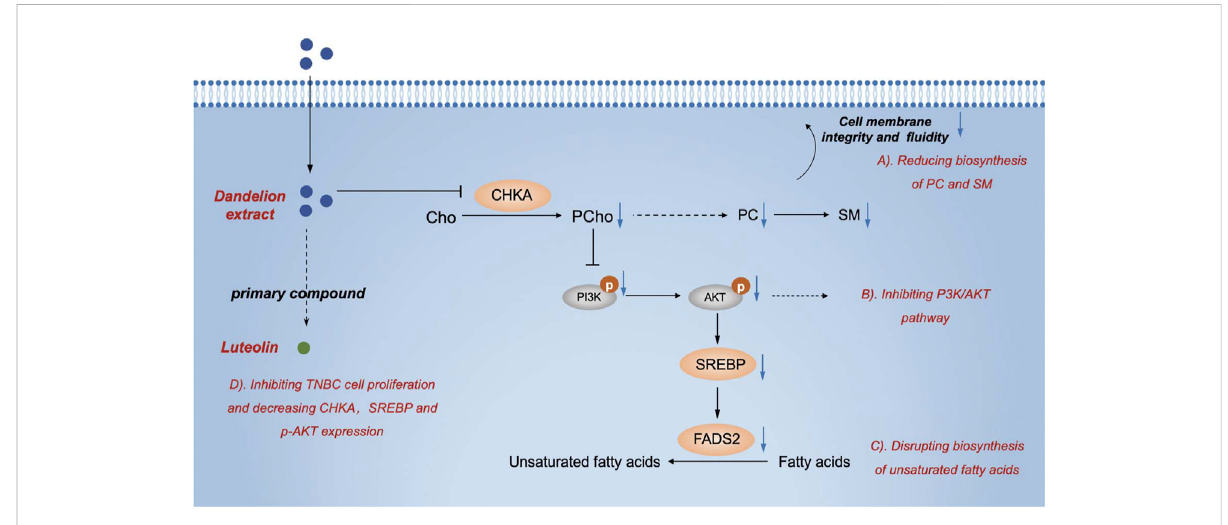
FIGURE 10 The graphic abstract of the lipid regulatory effects of dandelion extract against